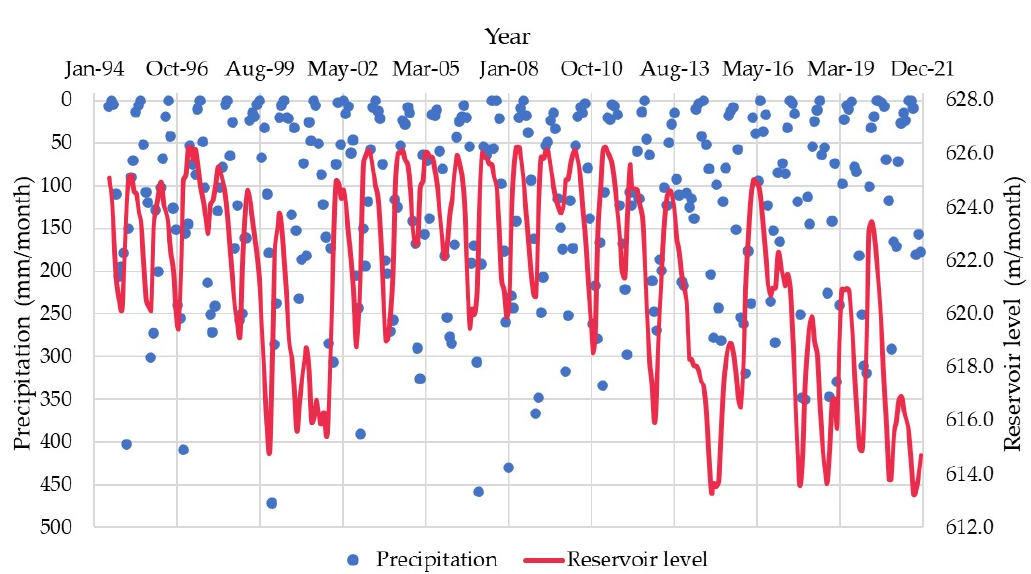
Figure 7. Average precipitation and reservoir levels at the Marechal Mascarenhas de Moraes, Furnas and Marimbondo HPPs (accumulation).